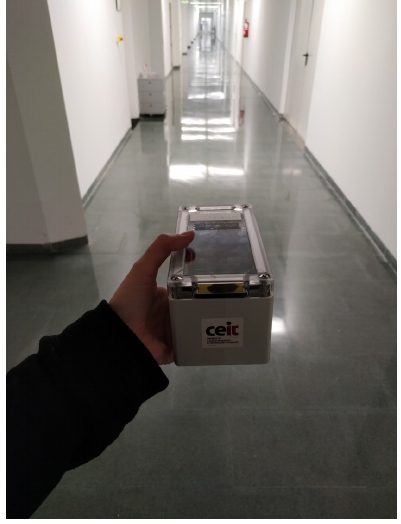
Figure 16. Test site for indoor coverage measurements at CEIT